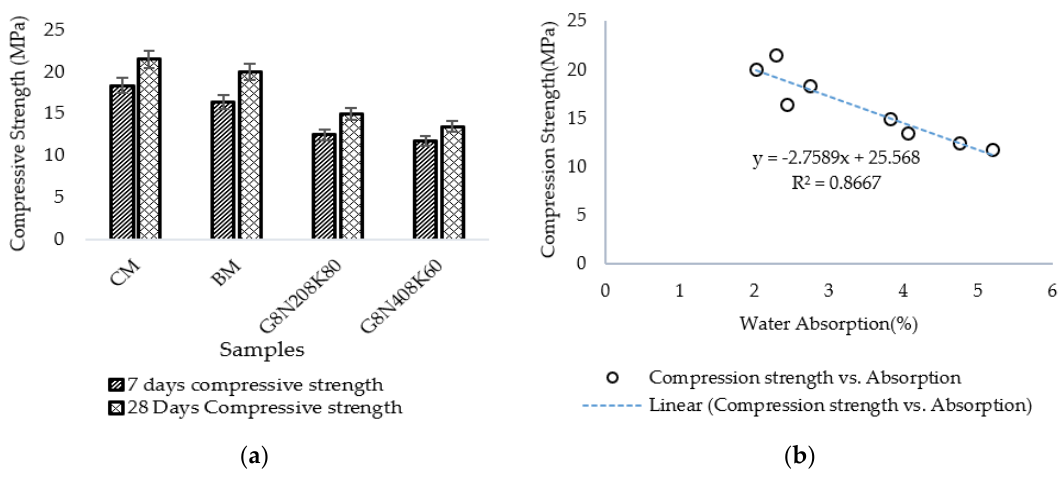
Figure 12. ( a ) Compressive strength of geopolymer samples at 7 and 28 days; ( b ) relationship between compression strength and water absorption.